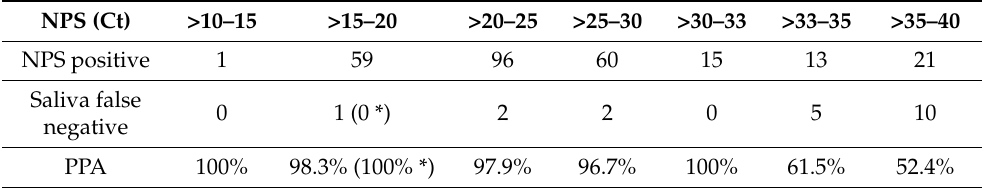
Figure 1. High agreement of SARS-CoV-2 detection in saliva and nasopharyngeal swabs (NPSs). ( A ) Contingency table, full cohort; ( B ) agreement values. PPA = positive percent agreement; NPA = negative percent agreement; OPA = overall percent agreement. ( C ) Summary of the full cohort (N = 1270 study participants). Roche Cobas E-gene Ct values of paired NPS and saliva samples are depicted. Red dots = adults; blue triangles = children; neg = PCR negative; black dashed line equals identity. Table 2. Positive percent agreement (PPA) stratified by NPS E-gene Ct